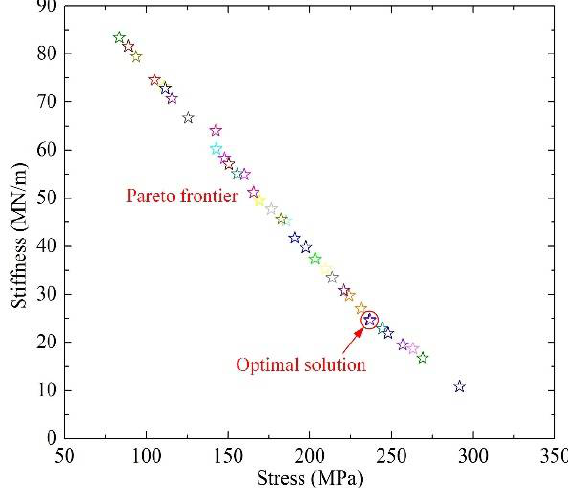
Figure 14. Patero optimal frontier using NSGA-II. Table 4. Comprehensive GRG using GRA.